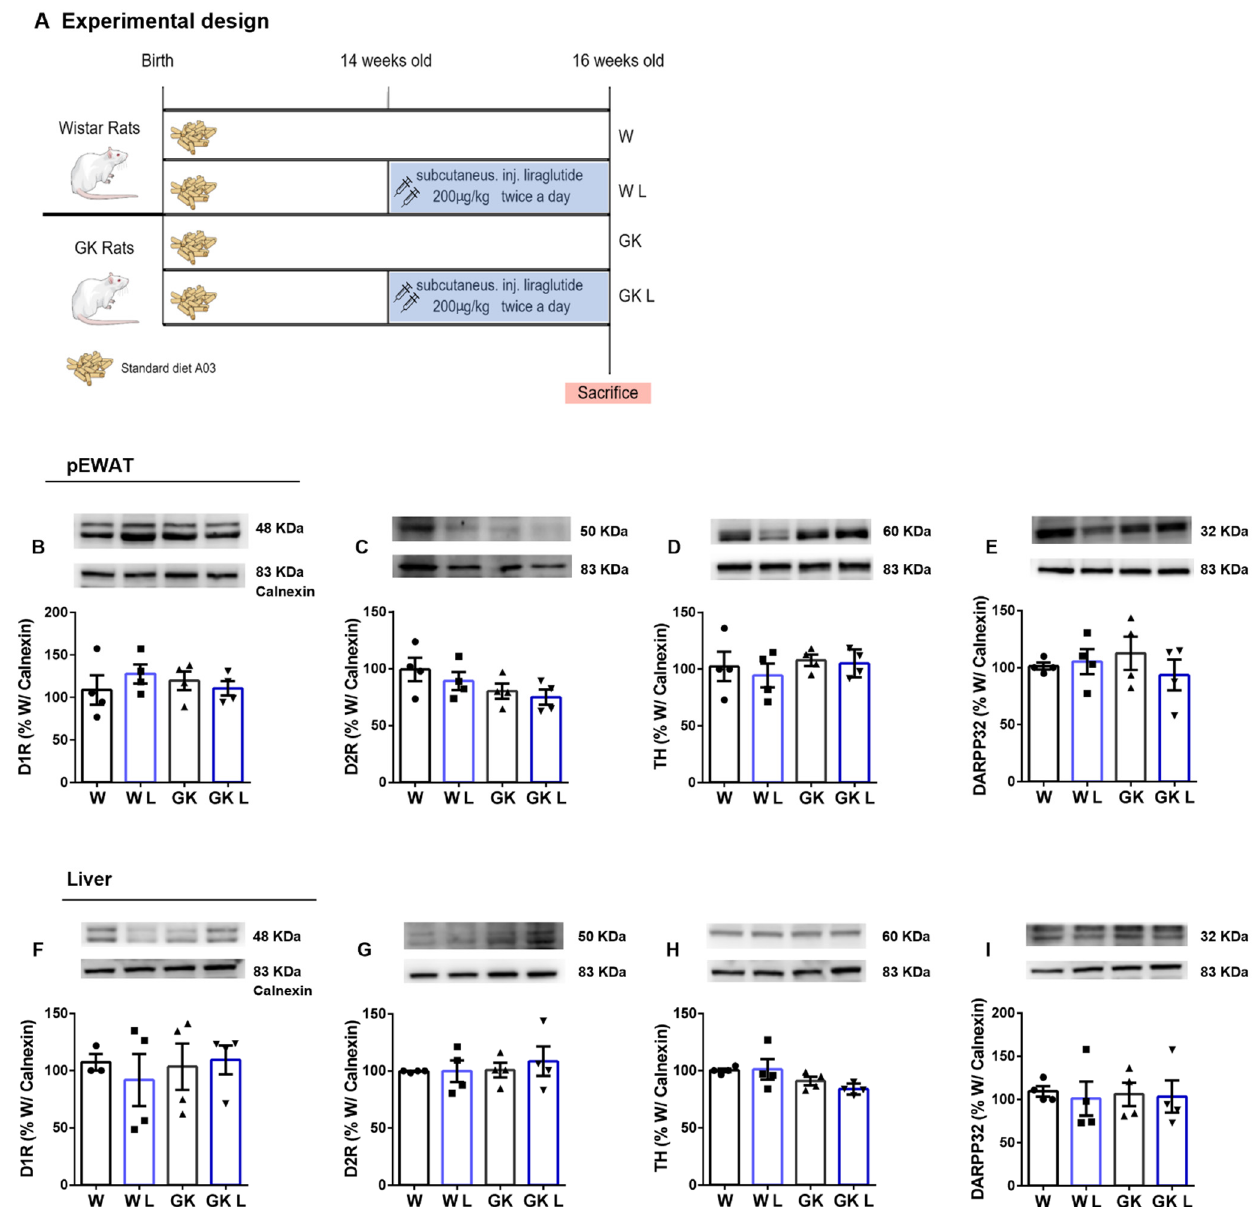
Figure 6. Dopaminergic signaling in peripheral tissues after liraglutide treatment. Liraglutide treatment (experimental design depicted in ( A )) did not alter D1R ( B ), D2R ( C ), TH ( D ), and DARPP-32 ( E ) levels in pEWAT. Similarly, in the liver, proteins from dopaminergic signaling re- main unchanged between groups after liraglutide treatment ( F , G , H , I ). Bars represent means ± SEM. Differences between groups were assessed by one-way ANOVA test with Tukey post-hoc corrections for multiple